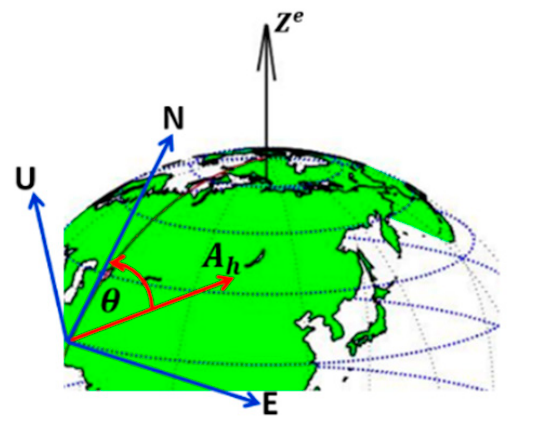
− based heading in Figure 6. Acceleration − based heading in LLF. Figure 6. Acceleration